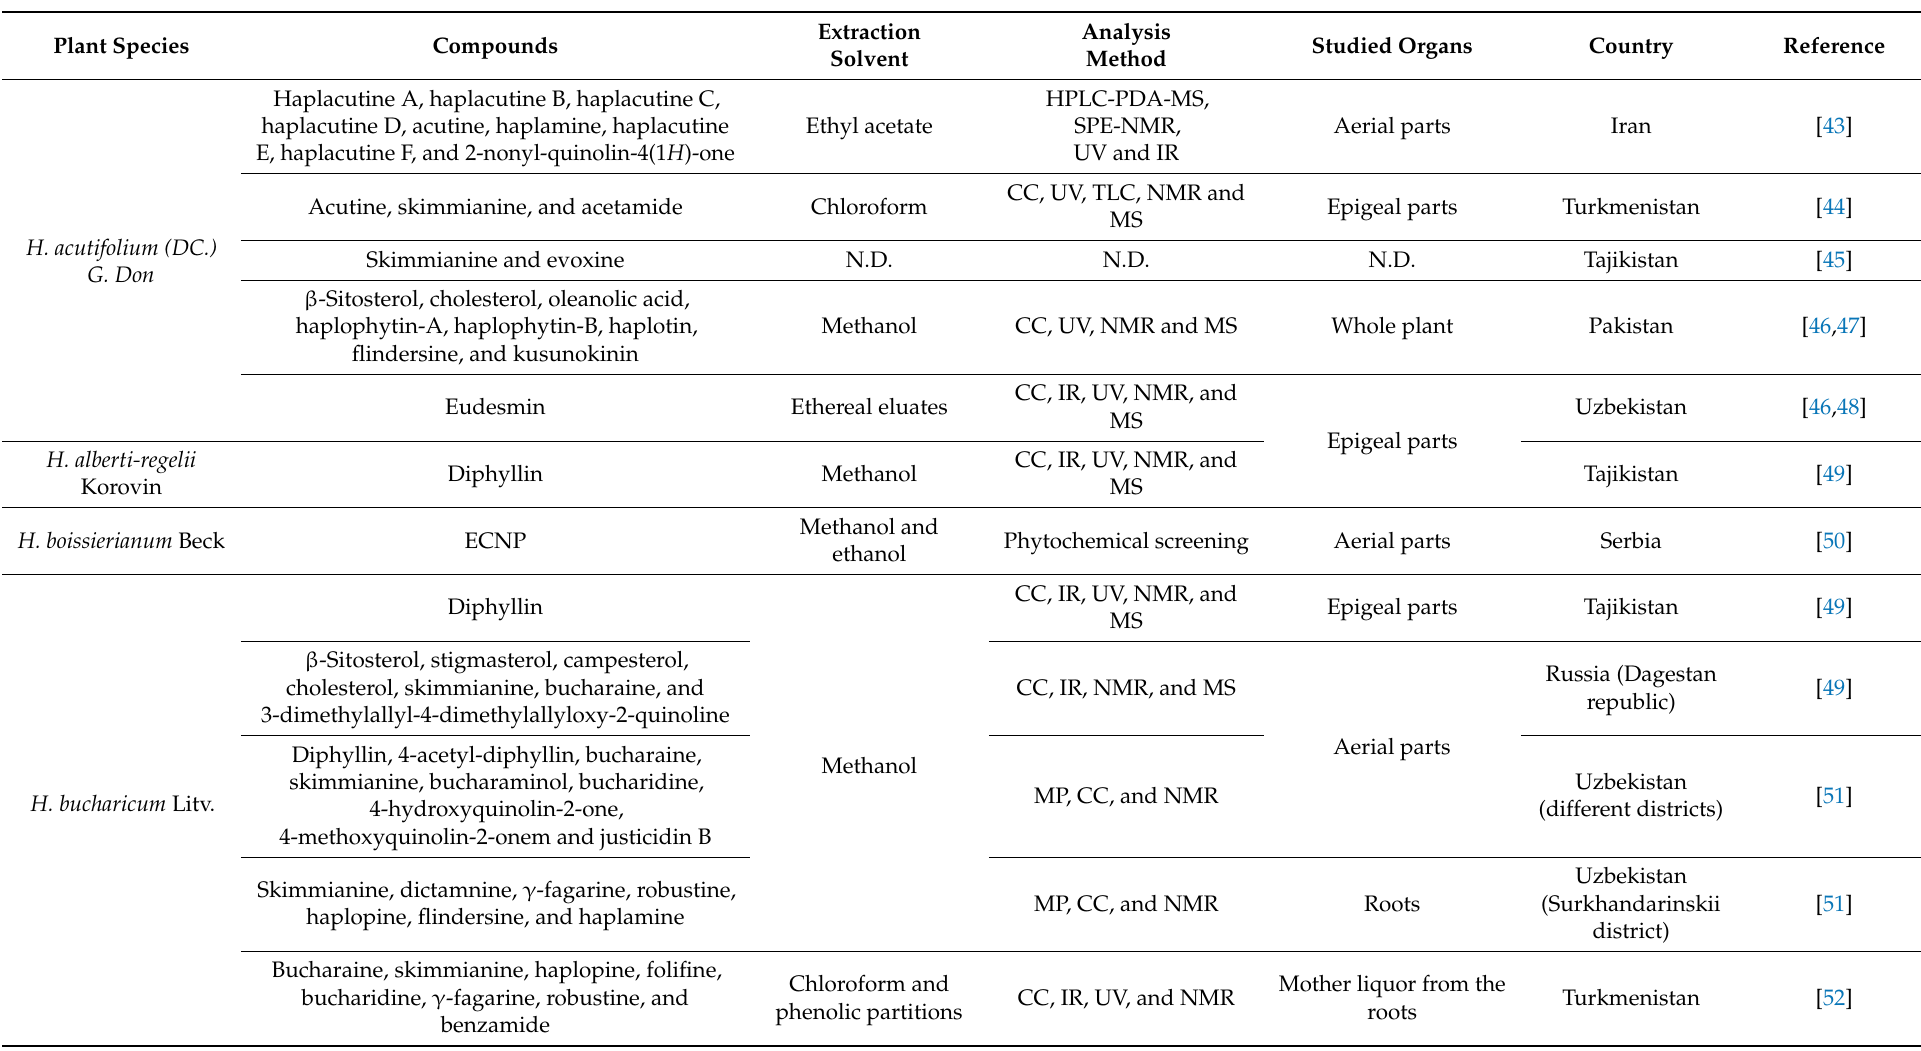
Table 3. Non-volatile compounds evidenced in Haplophyllum